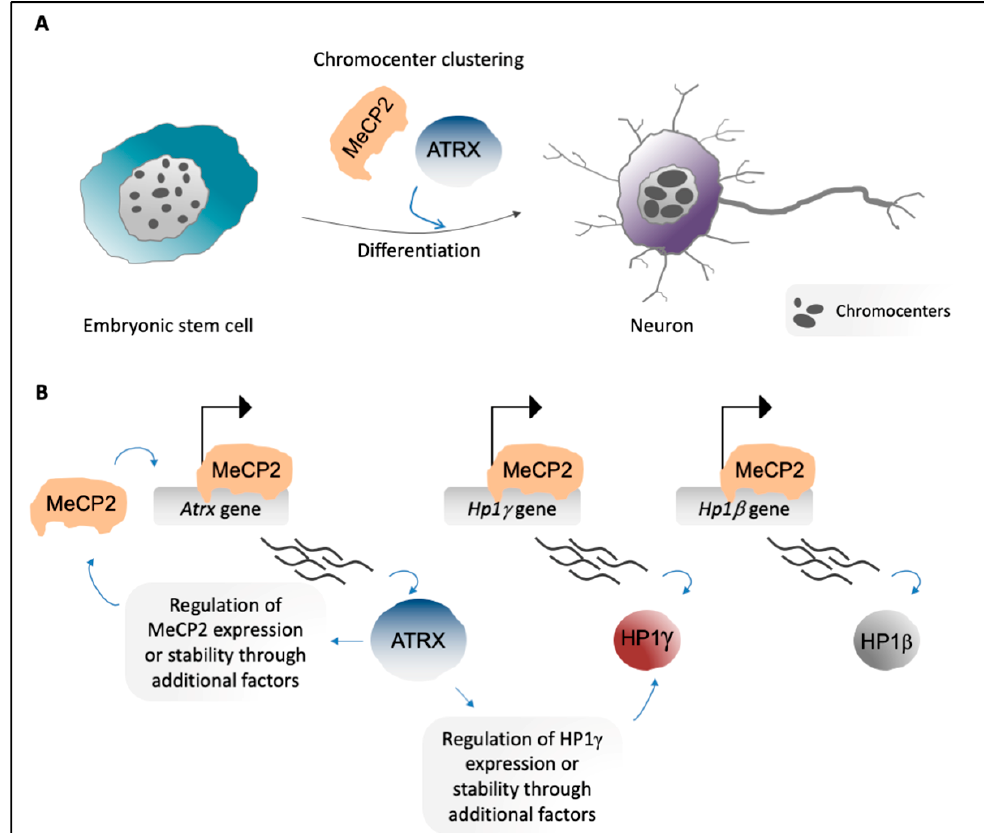
Figure 3. ( A ) Embryonic stem cells show high numbers of chromocenters per nucleus (left). In neurons, chromocenters increase in size and decrease in number due to aggregation of PCH of di ff erent chromosomes (chromocenter clustering) [18,20] (right). MeCP2 [18] and ATRX [20] are important players in chromocenter clustering during neural di ff erentiation. ( B ) MeCP2 directly promotes expression of genes that encode PCH-associated factors, including Atrx , Hp1 γ , and Hp1 β (top). ATRX regulates expression and / or stability of MeCP2 and HP1 γ , probably through the involvement of additional factors [20] (bottom).